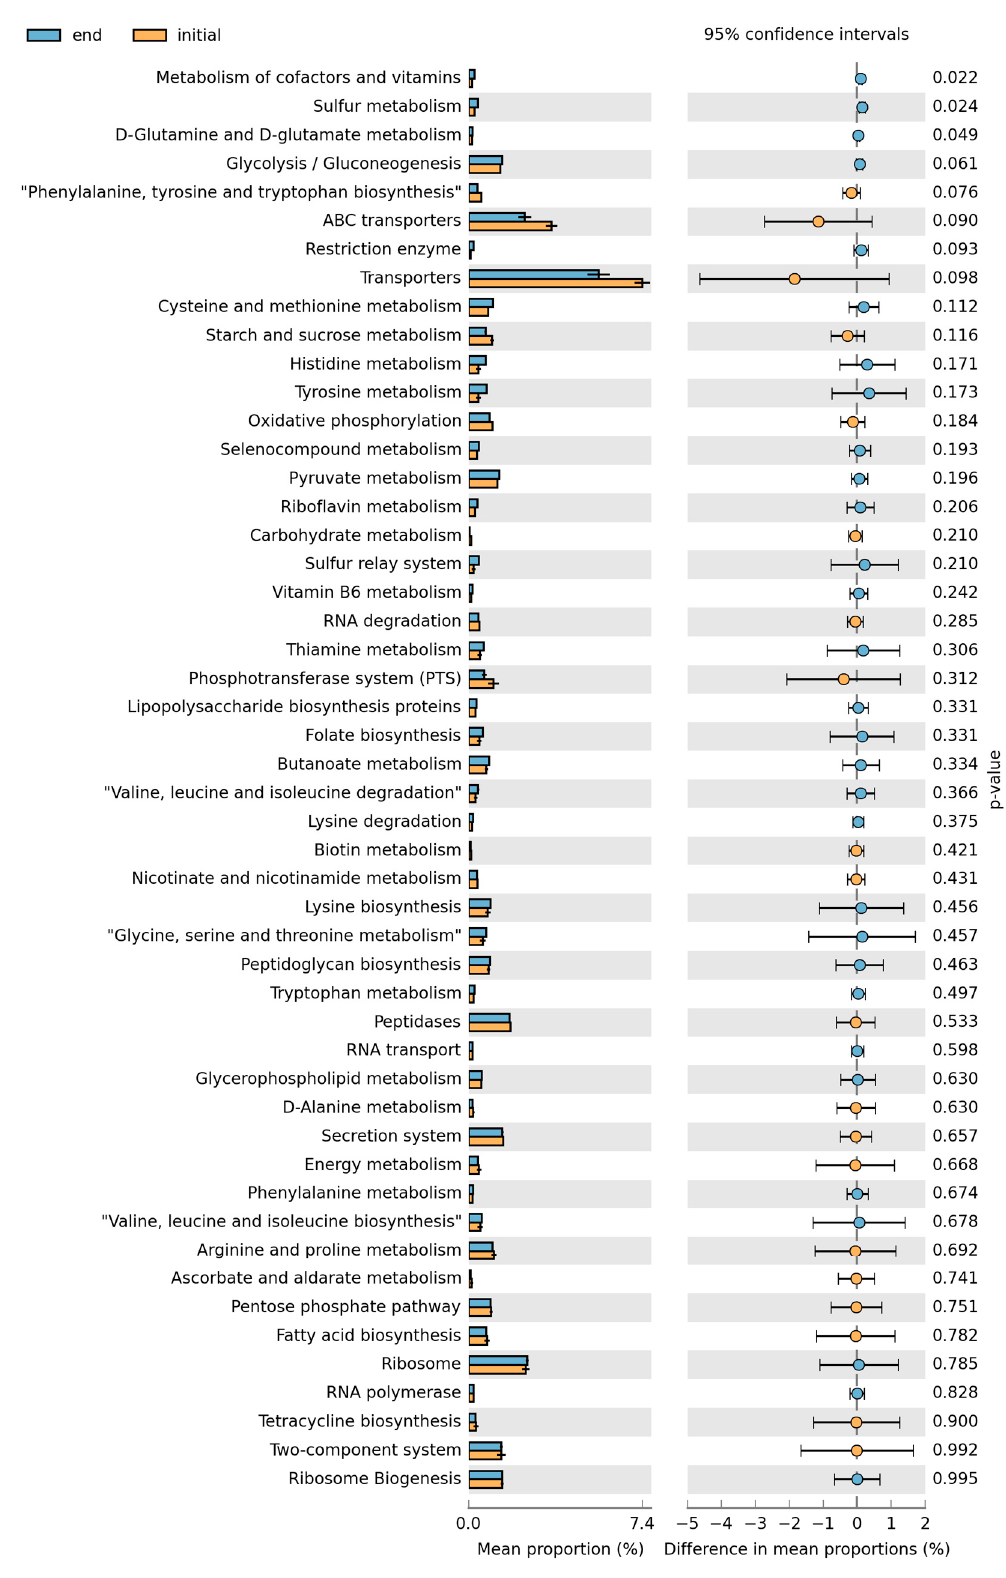
Figure 2. Micronutrient synthesis pathways in the kunu fermentations. The metagenomes were reconstructed and the pathways identified with PICRUSt. Pathways for the synthesis of vitamins and essential amino acids were identified in the metagenome. The figure was constructed from the fermentations A and B. Fermentation C was excluded due the high abundance of Clostridium that is not characteristic of cereal fermentations.